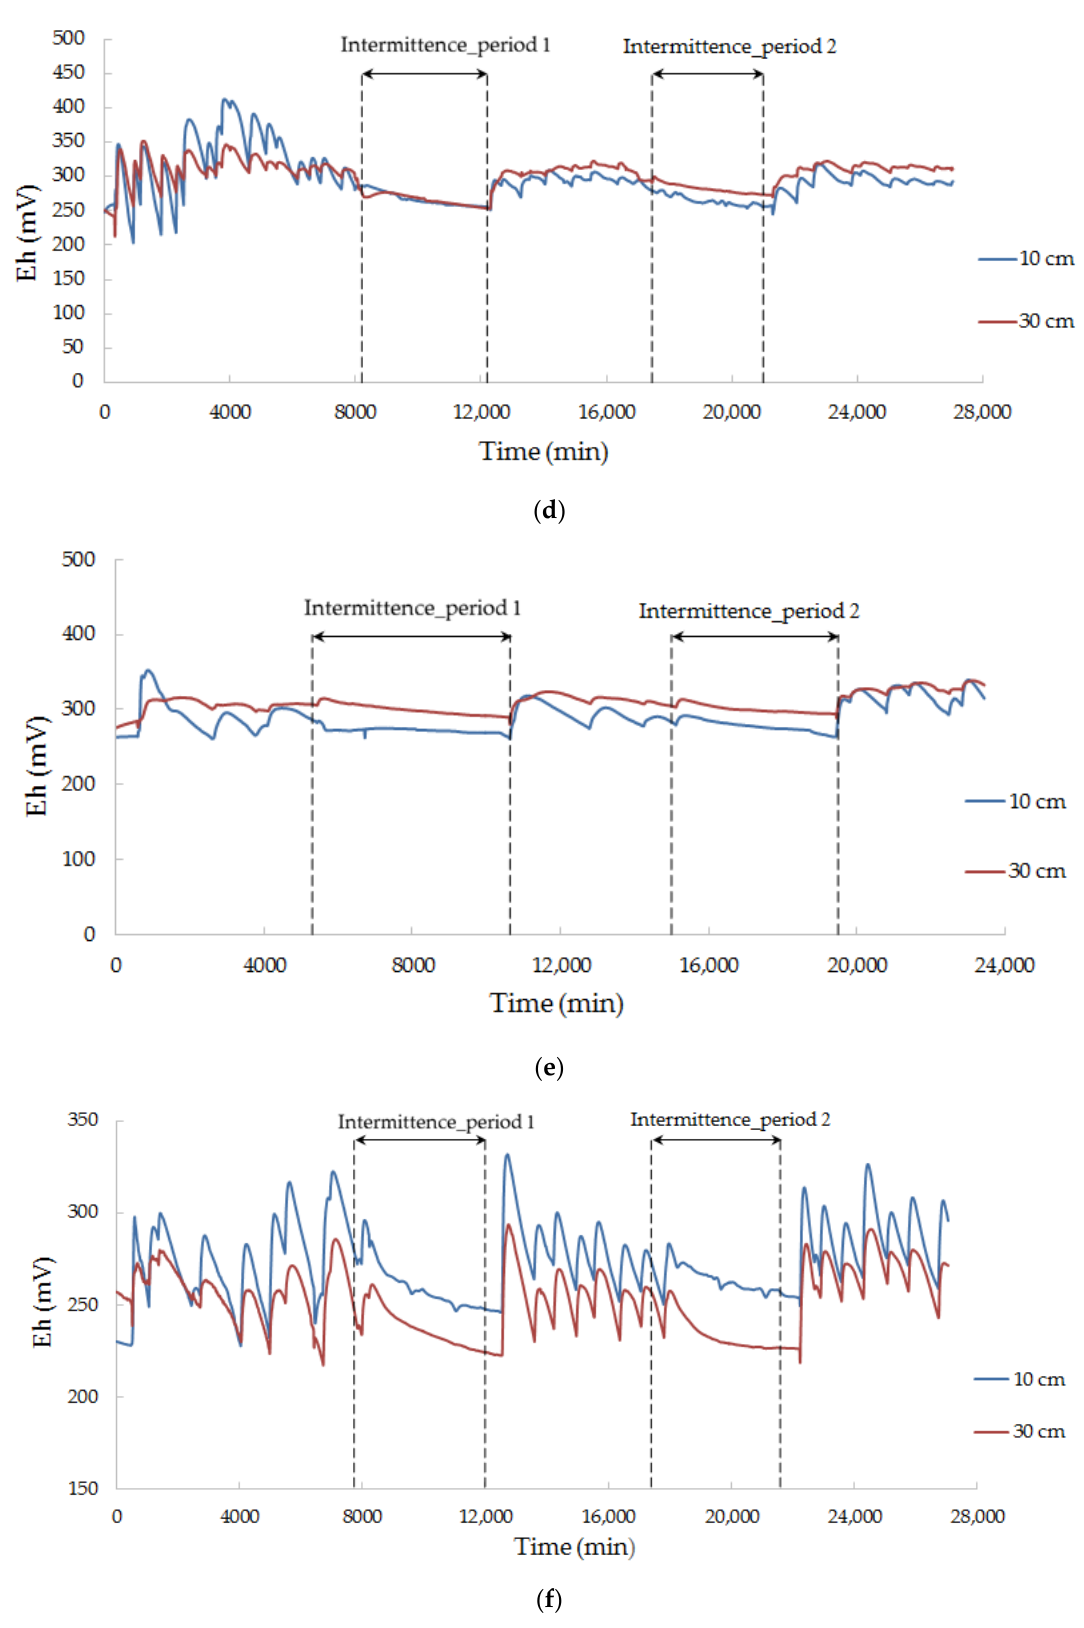
Figure 6. Redox potential change with time. ( a ) E1 (Fe + fine sand); ( b ) E2 (Fe + medium sand); ( c ) E3 (Zn + fine sand); ( d ) E4 (Zn + medium sand); ( e ) E5 (Pb + fine sand); ( f ) E6 (Pb + medium sand).